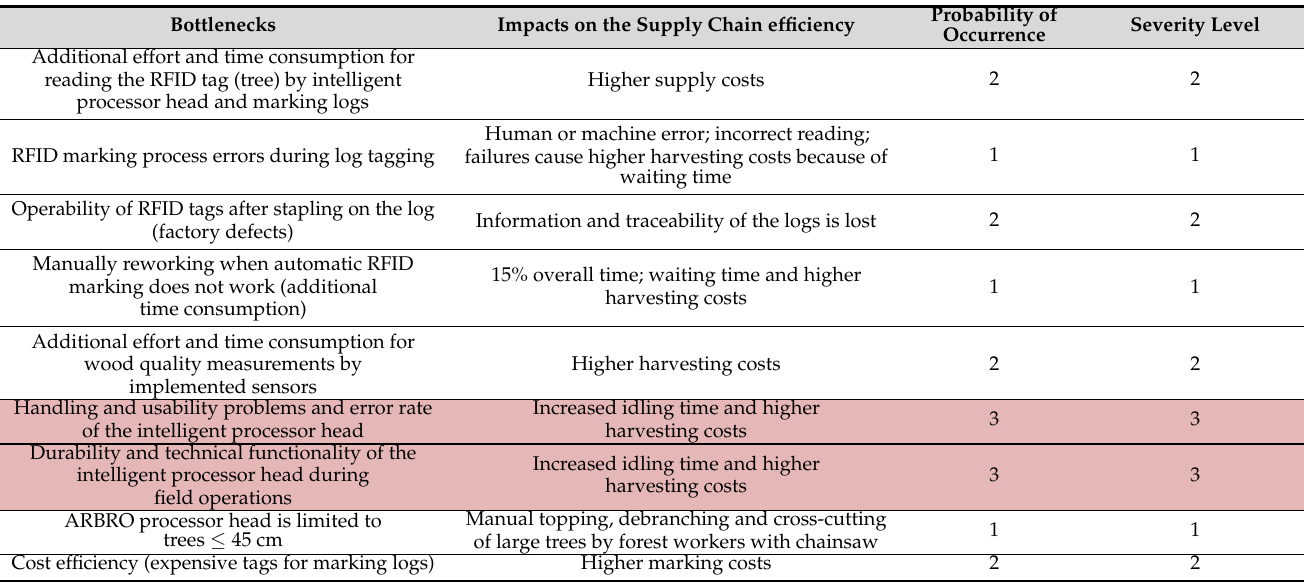
Table 8. Bottleneck and risk analyses of processing trees by the intelligent processor head. Scale classes: low (1), moderate (2), and high (3). Bottlenecks with a high probability of occurrence and a high severity level are marked in